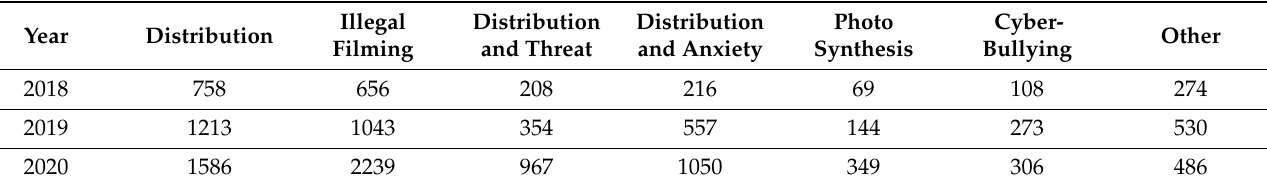
Table 2. Types of Digital Sex Crimes by Year [18].